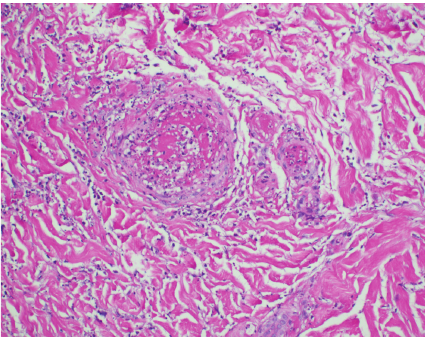
Figure 2: Skin biopsy in high power field showing leukocytoclastic